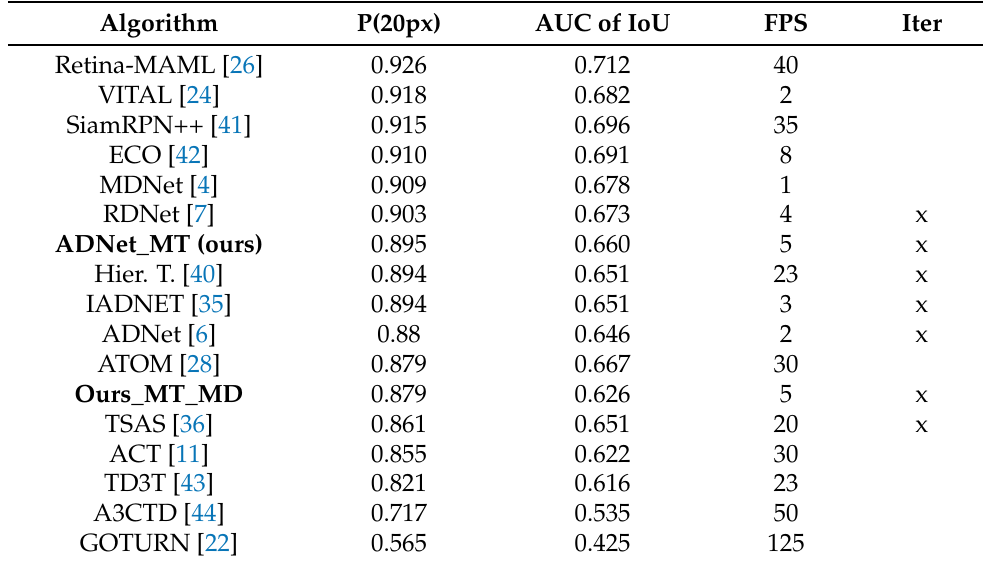
Table 1. Comparison on OTB-100. Iter indicates approaches using iterative refinements. P(20px) indicates the mean precisions when the location error threshold is 20 pixels. AUC of IoU is the area under the curve of the success plot computed by considering the IoU values.